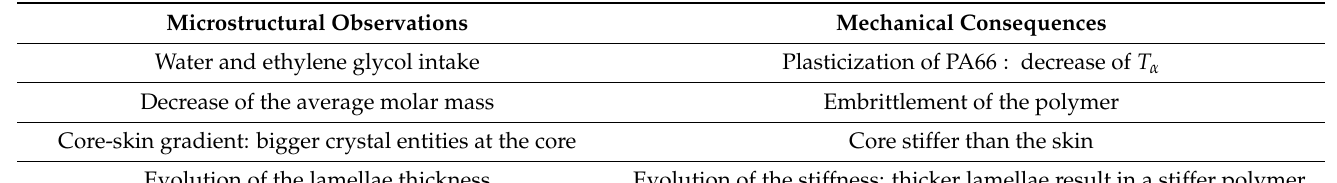
Table 4. Microstructure-properties relationships observed in an aged injection molded PA66.